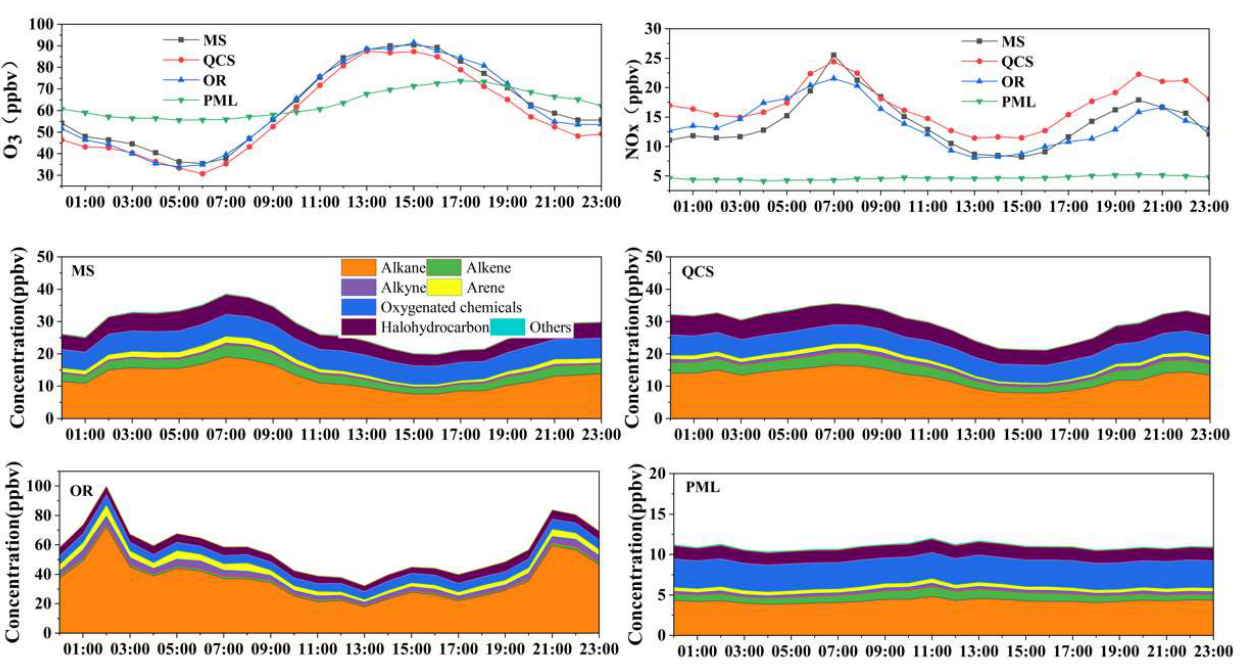
Figure 3. Average diurnal variation in the pollutant volume fractions at each site during the observation period.